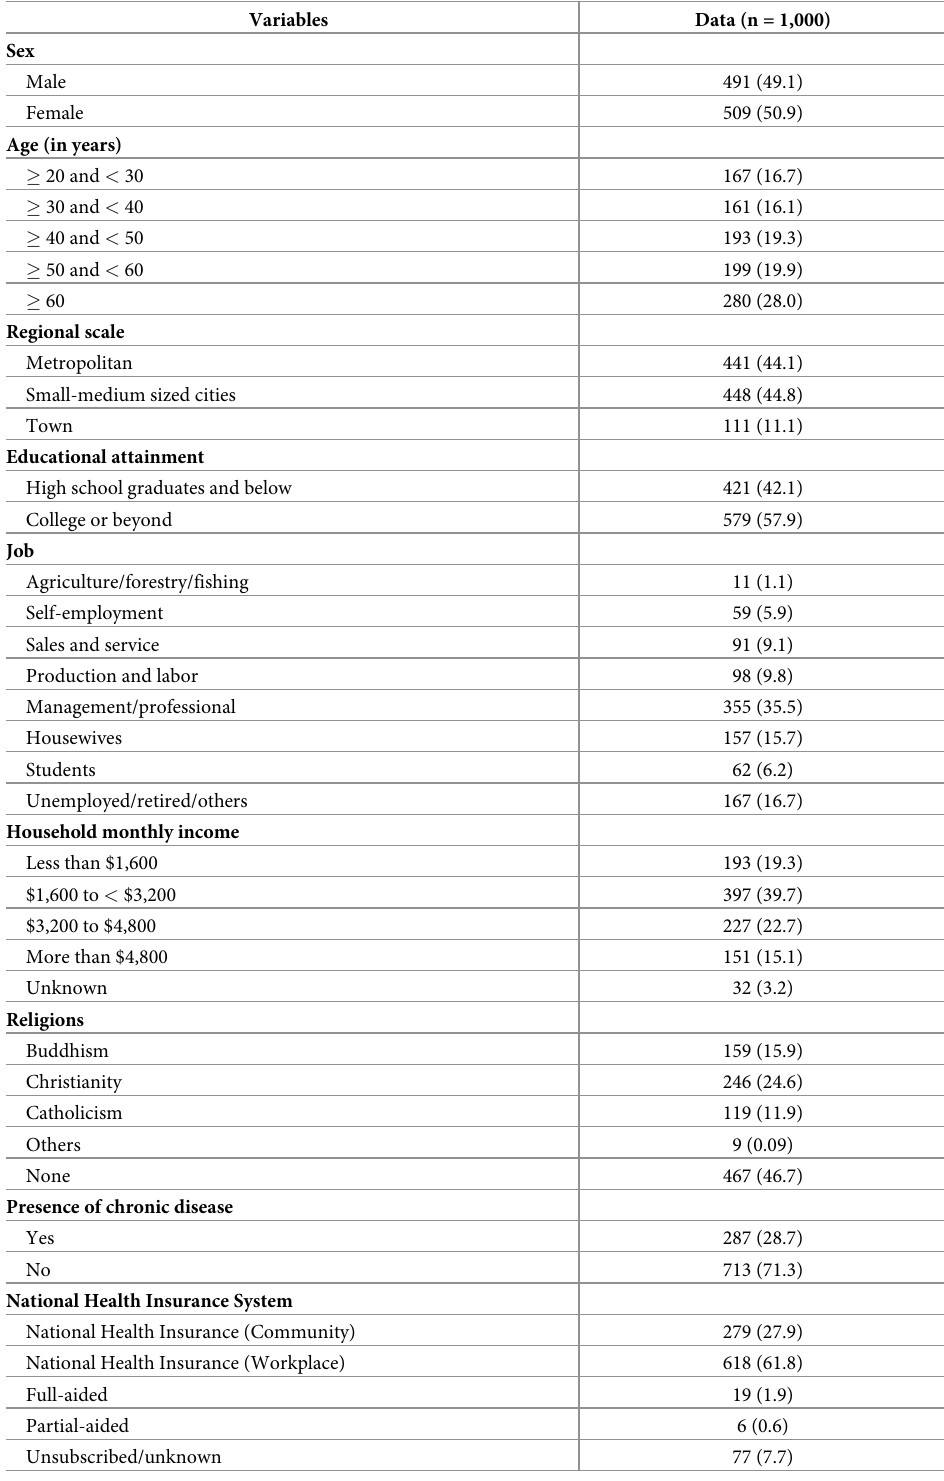
Table 1. Baseline characteristics of survey